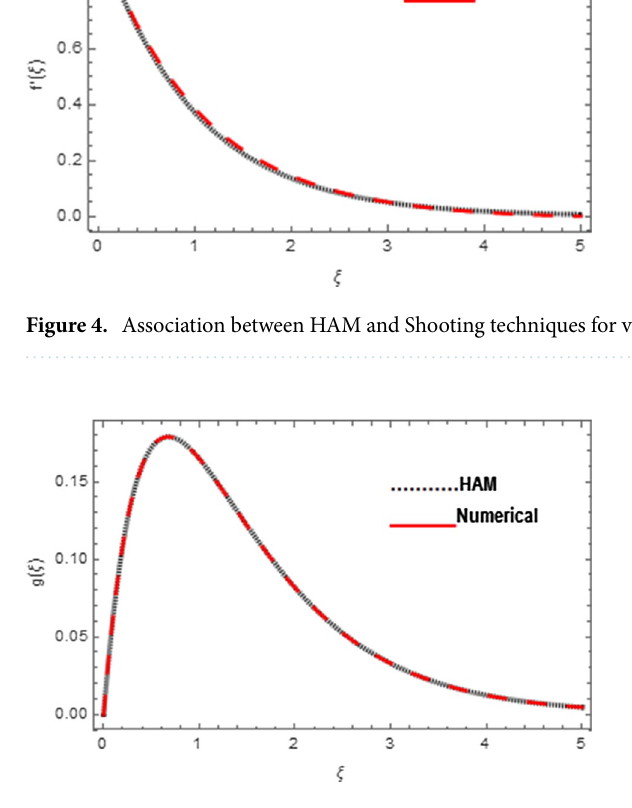
Figure 5. Association between HAM and Shooting techniques for microrotation field.